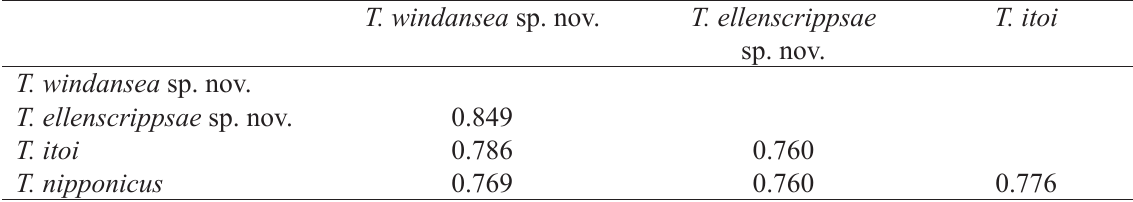
Table 6. Comparison of similarities between COI gene fragments in species of Trilobodrilus Remane, 1925. For accession numbers of the used sequences see Table 3.